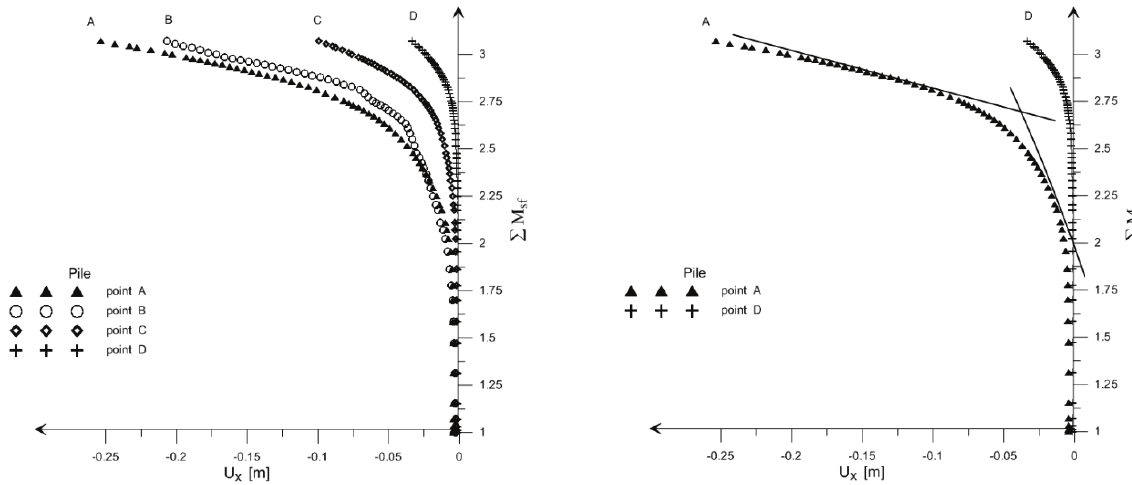
Fig. 16. Determining safety factor for measurement points in a pile (excavation depth 4